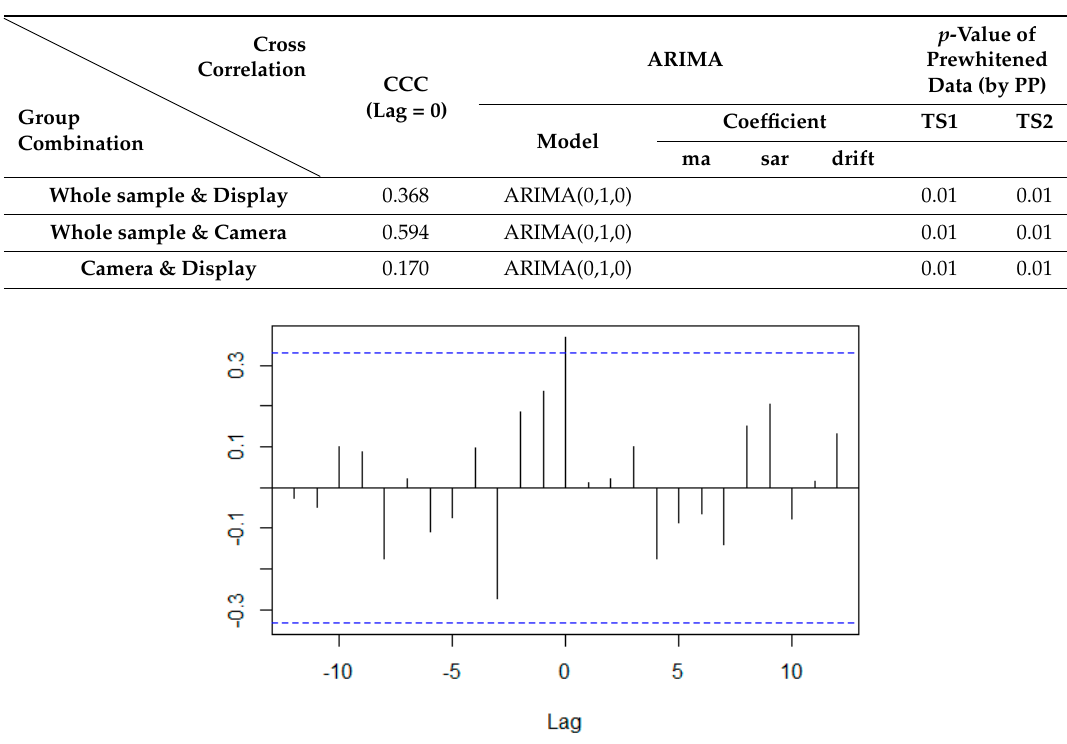
Figure 14. Cross-correlation coefficient between the average BHAR of the whole sample group and the average BHAR of the display group for Jan 2010–Dec 2012.